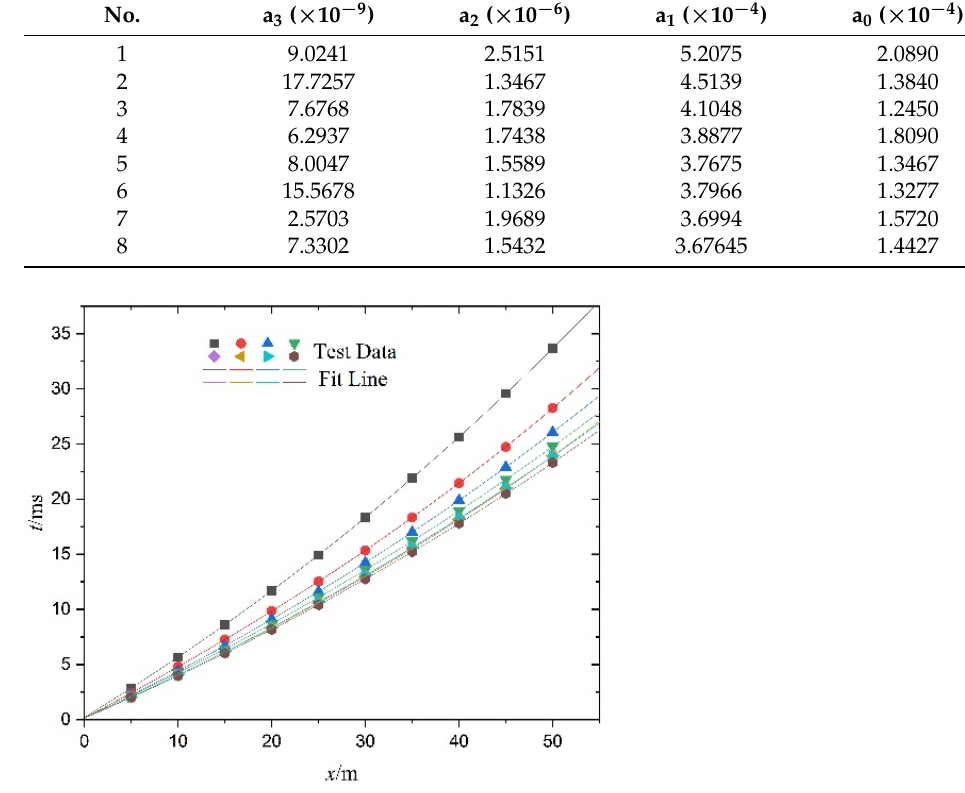
Figure 8. Distance–time fitting curve. Table 5. Fitting parameters of fragment motion